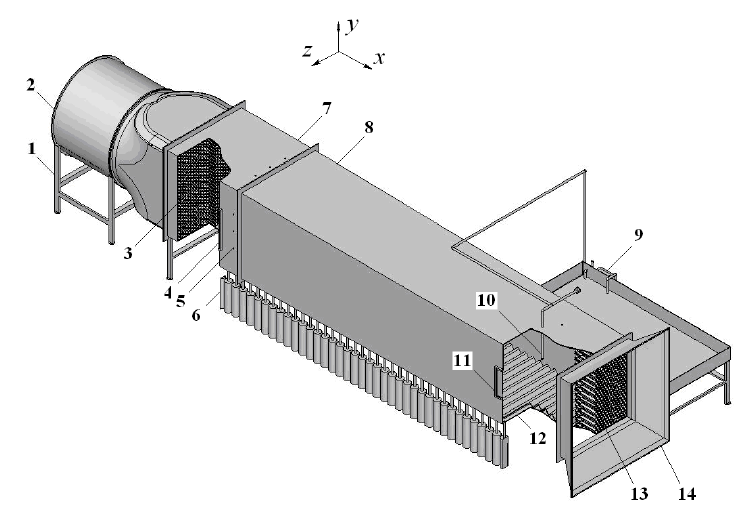
Figure 1. Wind tunnel for spray drift experiments: 1—frame; 2—suction fan with electric motor; 3, 13—air flow straighteners; 4, 11—window; 5—air velocity measurement place; 6—flask; 7—connection chamber; 8—investigation chamber; 9—spray supply equipment; 10—nozzle; 12—corrugated tin; 14—air intake section.